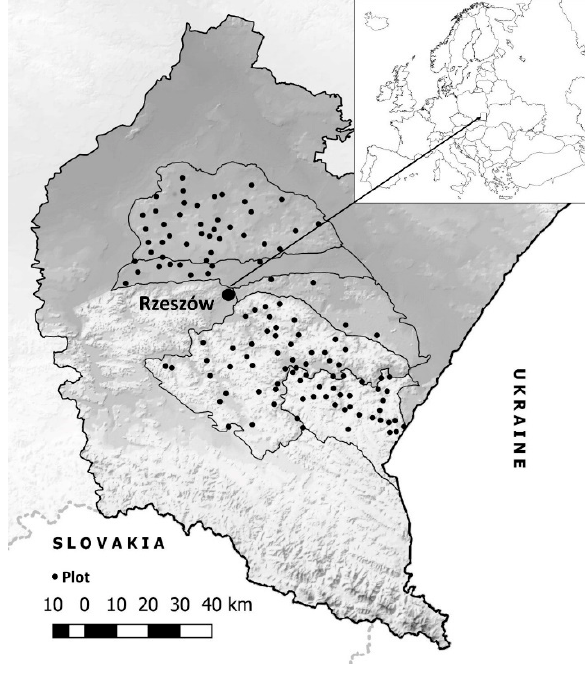
Figure 1. Research area.